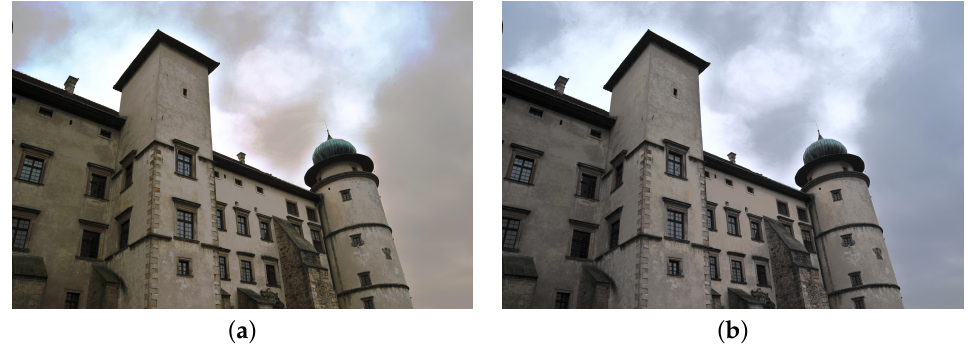
Figure 9. Image transformed with the use of exact histogram matching in RGB ( a ) and L*a*b* space ( b